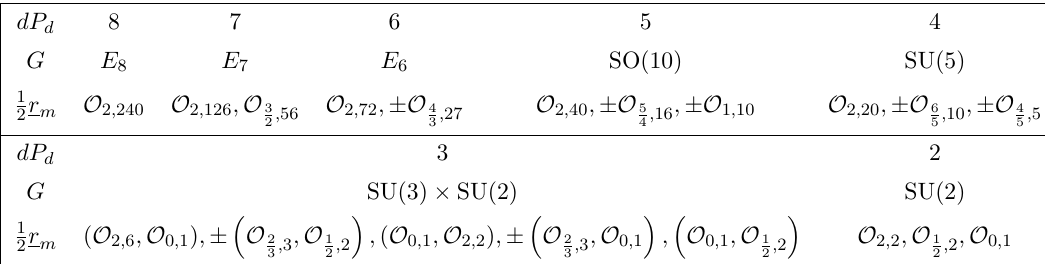
Table 9 . r components of mass parameters for dP d ( d (cid:21) m